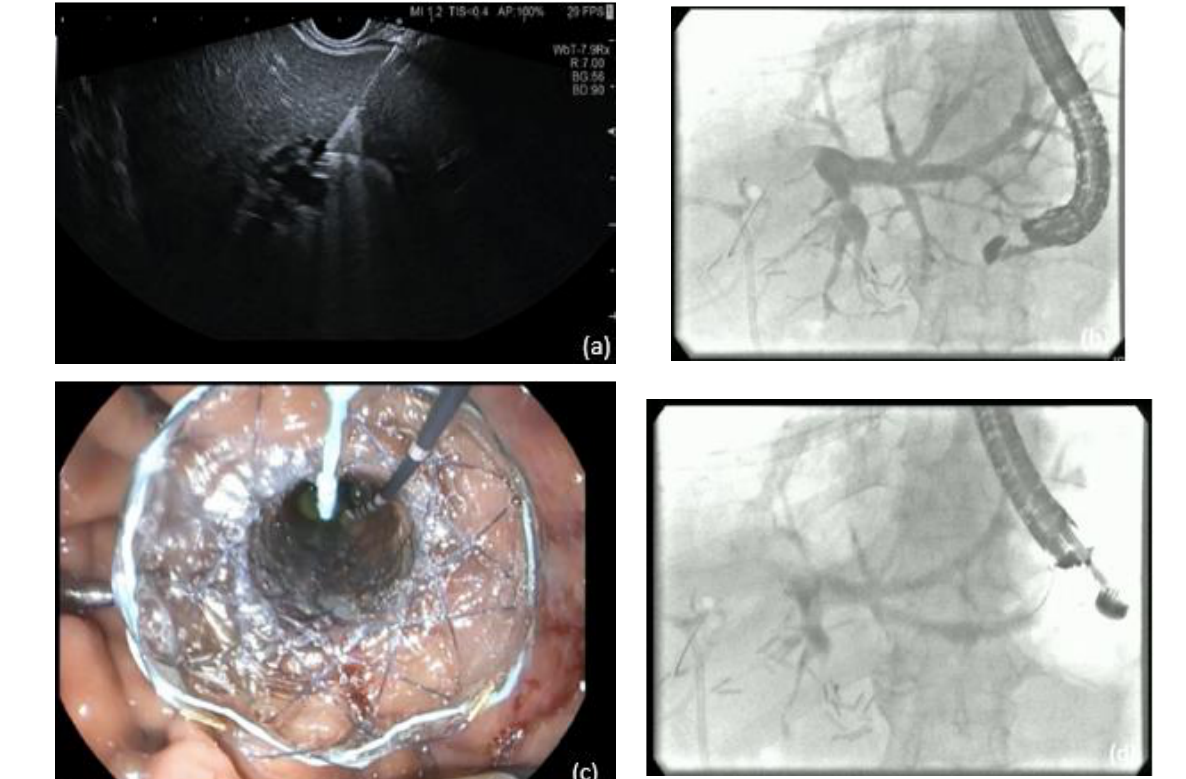
Figure 5. EUS-guided hepaticogastrostomy (EUS-HGA) in malignant hilar obstruction and failure of transpapillary drainage of the left liver lobe. ( a ): EUS guided puncture of a dilated bile duct in segment III; ( b ) insertion of a guidewire to the hilum after aspiration of bile and injection of contrast medium; ( c ) endoscopic aspect of the gastric flange of a dedicated partially covered self-expandable metal stent after deployment into the HGA. ( d ): Fluoroscopic image of the fully expanded stent with subtotal drainage of the contrast medium into the stomach through the stent.